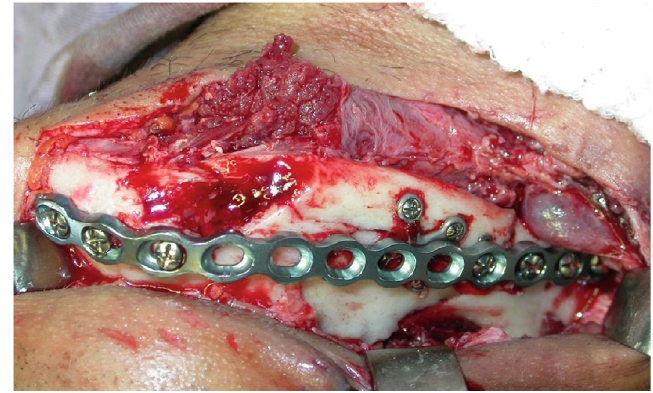
Figure 9: Rebuild plate installation overlapping stabilization